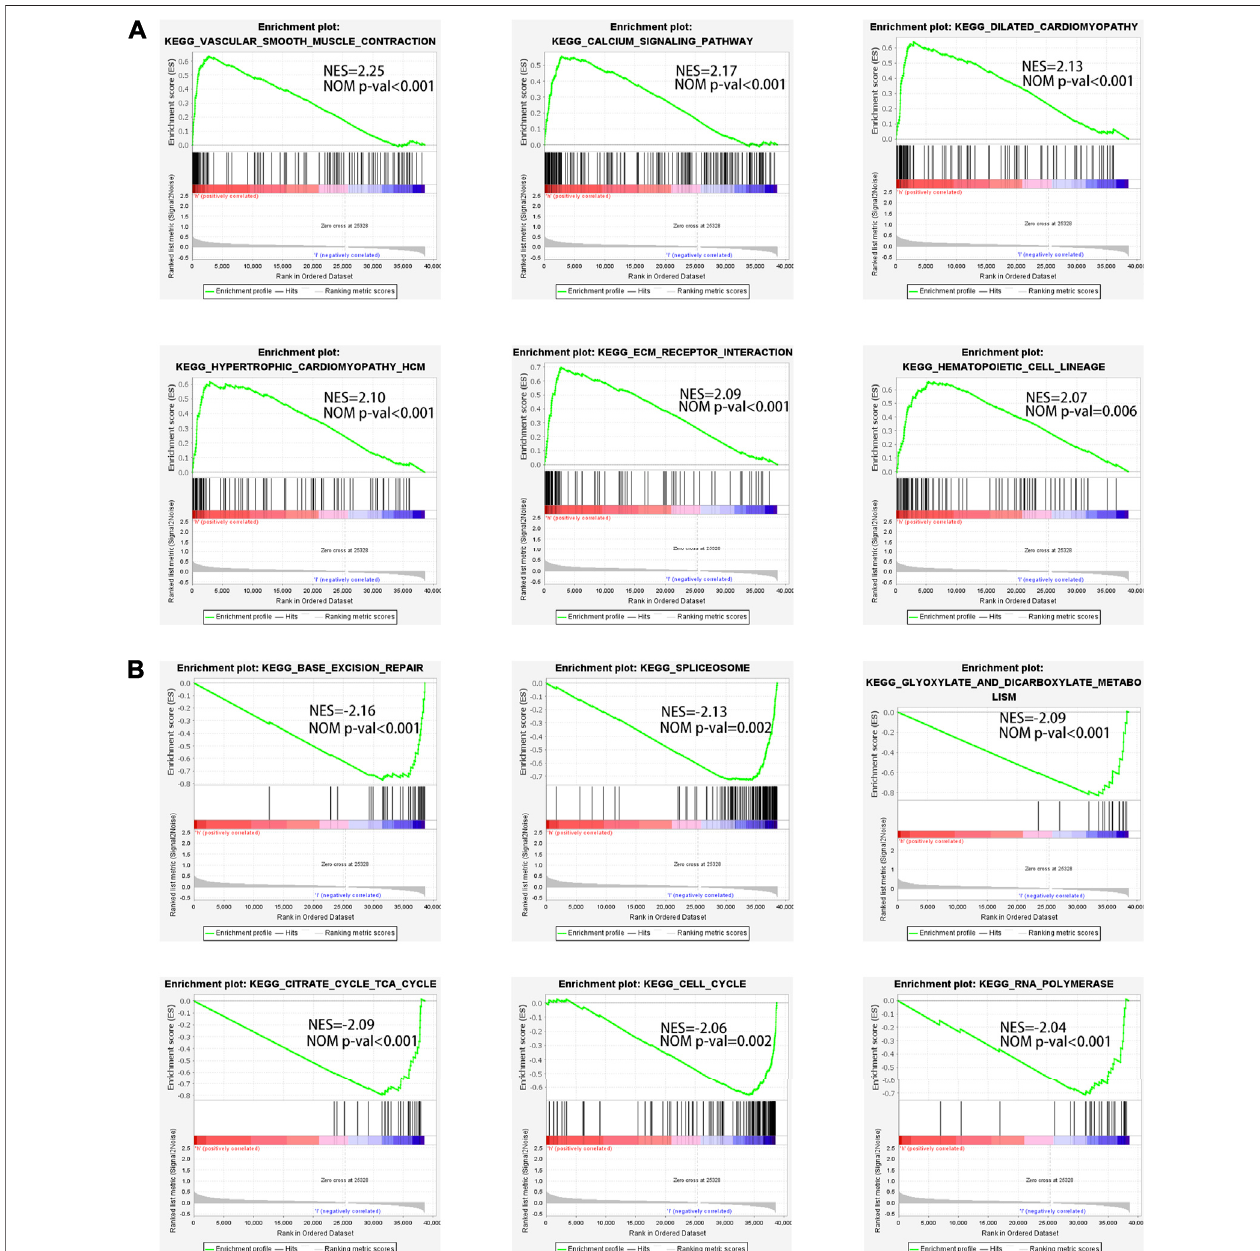
FIGURE6| Theenrichedpathwaysinhigh-riskandlow-risksubsetsobtainedusingthe12-NRLssignature. (A) Top6signi fi cantlyenrichedKEGGpathwaysinthe high-risk subset. (B) Top 6 signi fi cantly enriched KEGG pathways in the low-risk subset.